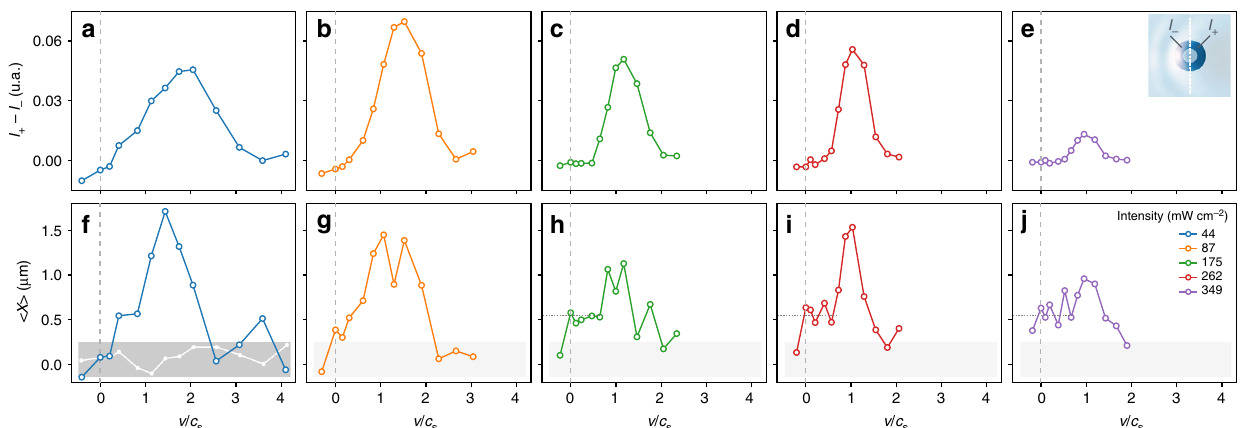
Fig. 3 Optical analog of the drag force exerted by the fl uid and associated displacement of the obstacle. a – e Local intensity difference I + − I − extracted from the experimental images of the intensity of the fl uid-of-light beam measured at the crystal ’ s output for various input conditions ( I f ranging from 44 ( a ) to 349 ( e ) mW cm − 2 and v / c s ranging from − 0.41 to 4.10). Inset of e : the original image is cropped around the optical defect and integrated over two regions, downstream ( I − ) and upstream ( I + ). The typical integration area is of the order of ξ . The grey dotted line corresponds to v / c s = 0. f – j Measurement of the transverse displacement of the obstacle induced by the local modulation of the intensity of the fl uid of light for the same input conditions as for fi gures a – g . Grey boxes de fi ne the typical uncertainty in the measured quantities, the white points in f corresponding to the displacement along the y axis for I f = 44 mWcm − 2 , which is expected to be